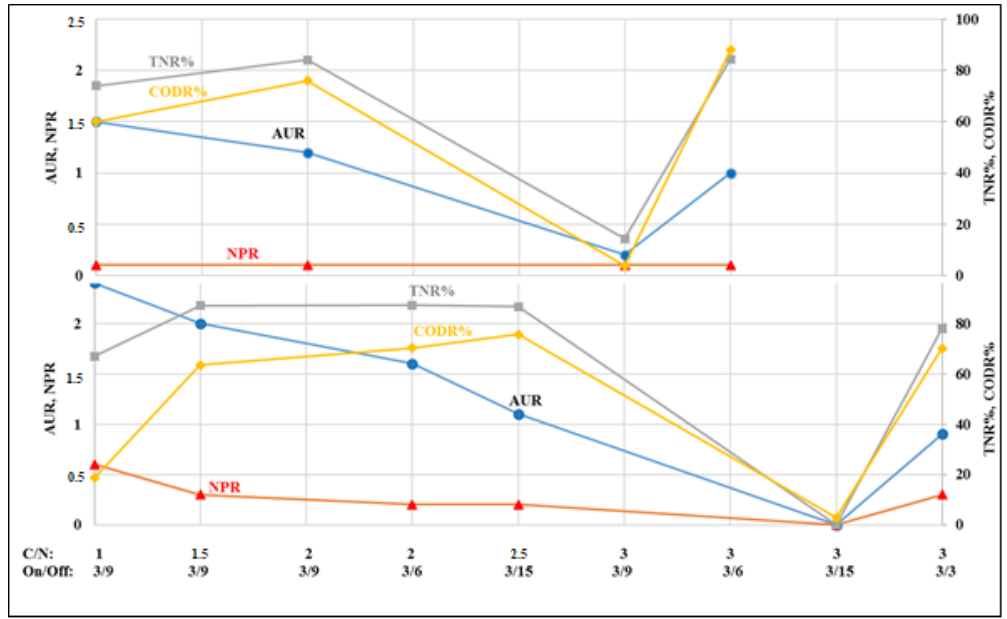
Figure 5. Influence of C/N ratios and aer/non-aer times on TN removal efficiency and COD removal efficiency in both series.